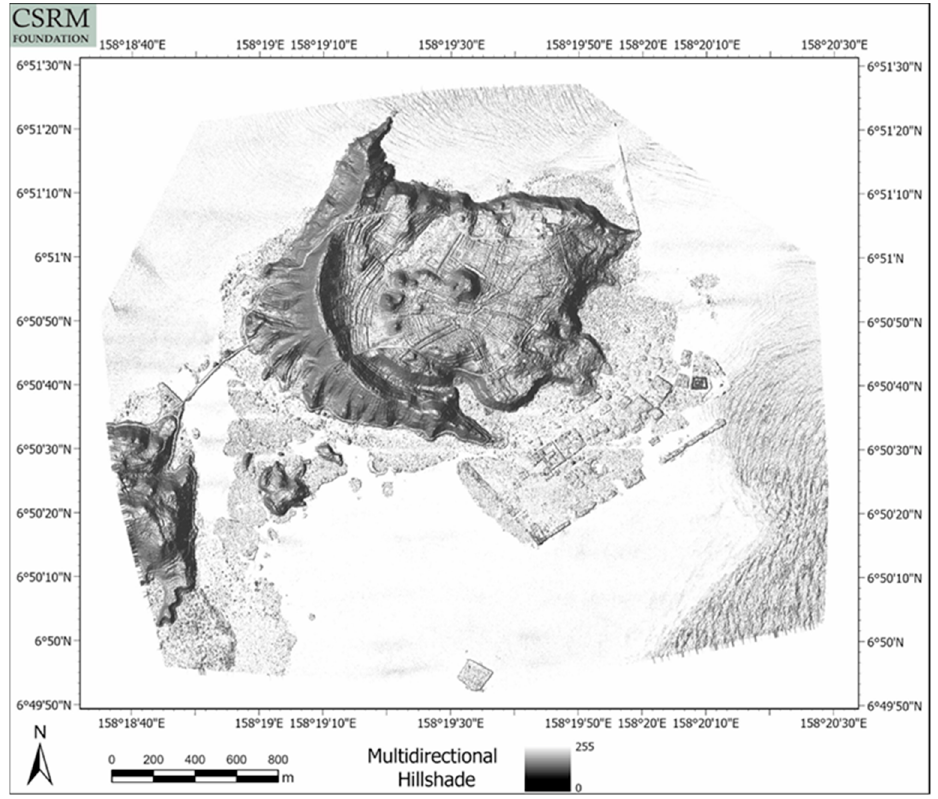
Figure 4. A grayscale, multidirectional hillshade image, derived from the LiDAR data set using ArcGIS Pro software. Both the cultivation features on Temwen Island and Nan Madol’s islets are discernible.